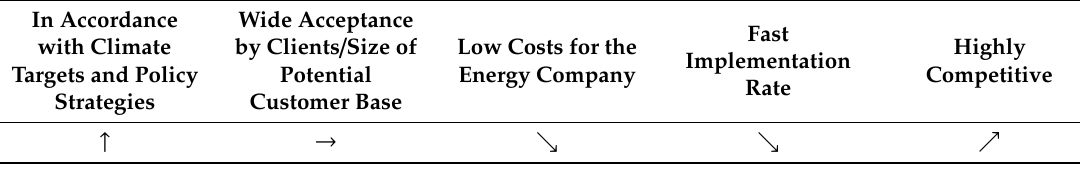
Table 4. Assessment of rolling out public infrastructure for e-mobility as a business model for energy